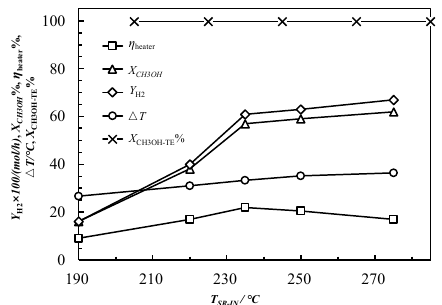
Figure 8. Variation in Y H 2 , X CH 3 OH , and ∆ T of module (1), as well as η heater and X CH 3 OH-TE %, with the reforming channel inlet temperature.